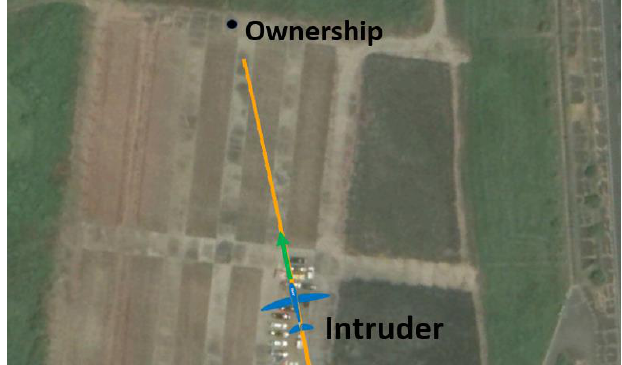
Figure 29. Flight path of the intruder in Experiment 4.